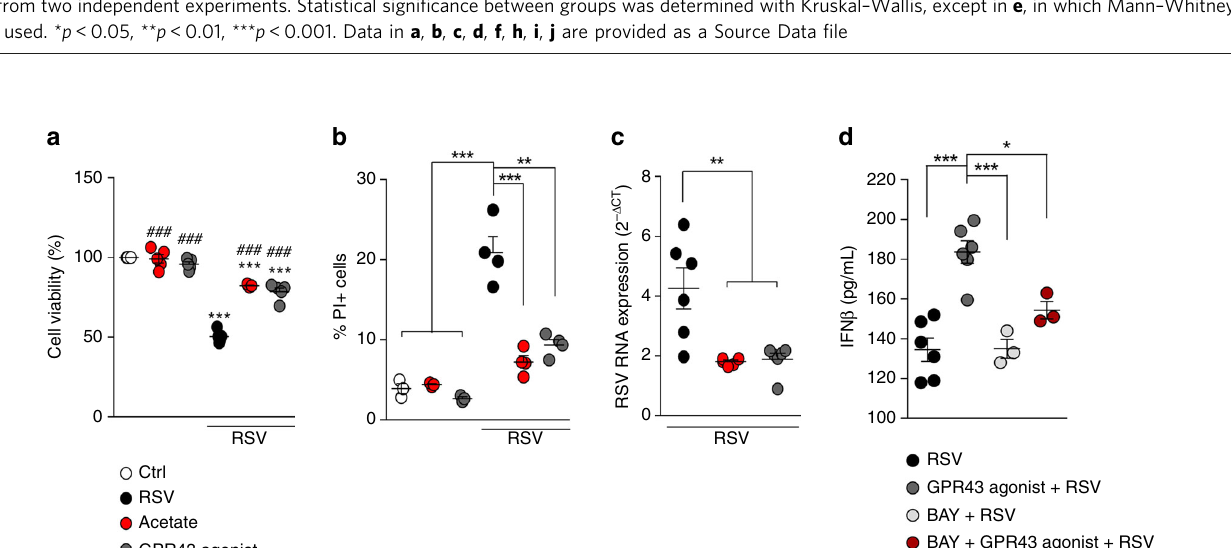
Fig. 7 Acetate protects against RSV infection in an IFNAR-dependent manner. Female BALB/c mice were treated with 200 mM acetate in drinking water and infected with RSV (10 7 PFU/mL) for 24, 48, 72, and 120 h. a Ifnb1 gene expression in the lung detected at different time points after infection (2- Δ Ct analysis in real-time PCR) ( n = 5). b IFN- β protein detected in the BALF or lung homogenates c at different time points after infection ( n = 5). d Oas1 and Isg15 gene expression in the lung (2- Δ Ct analysis in real-time PCR) ( n = 5). e Pulmonary epithelial cells from female naïve BALB/c mice were treated with acetate (260 µ M) for 24 h and then infected with RSV (10 4 PFU/mL) for a further 24 h to detect IFN- β production (by ELISA) and Ifnb1 expression (fold change compared to untreated/uninfected control) ( n = quadruplicate mean of 4 animals). f Ifnb1 expression of CD45 + CD326 - and CD45 - CD326 + sorted cells from lung of mice acetate-treated and RSV-infected for 72 h (n = 5). g IFN- β production by alveolar macrophages of mouse untreated or treated with